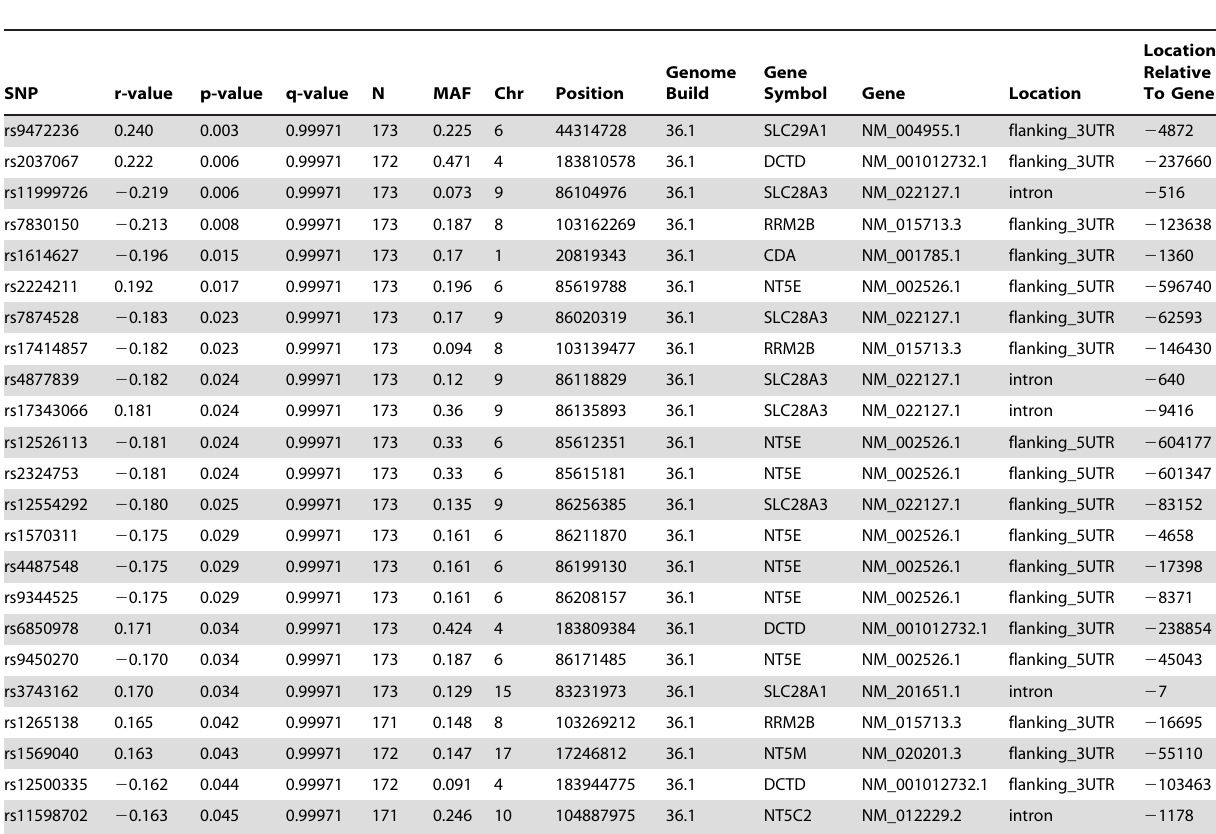
Table 4. Top 23 significant SNPs within or close to 9 pathway genes associated with AraC IC 50 values (p , 0.05).